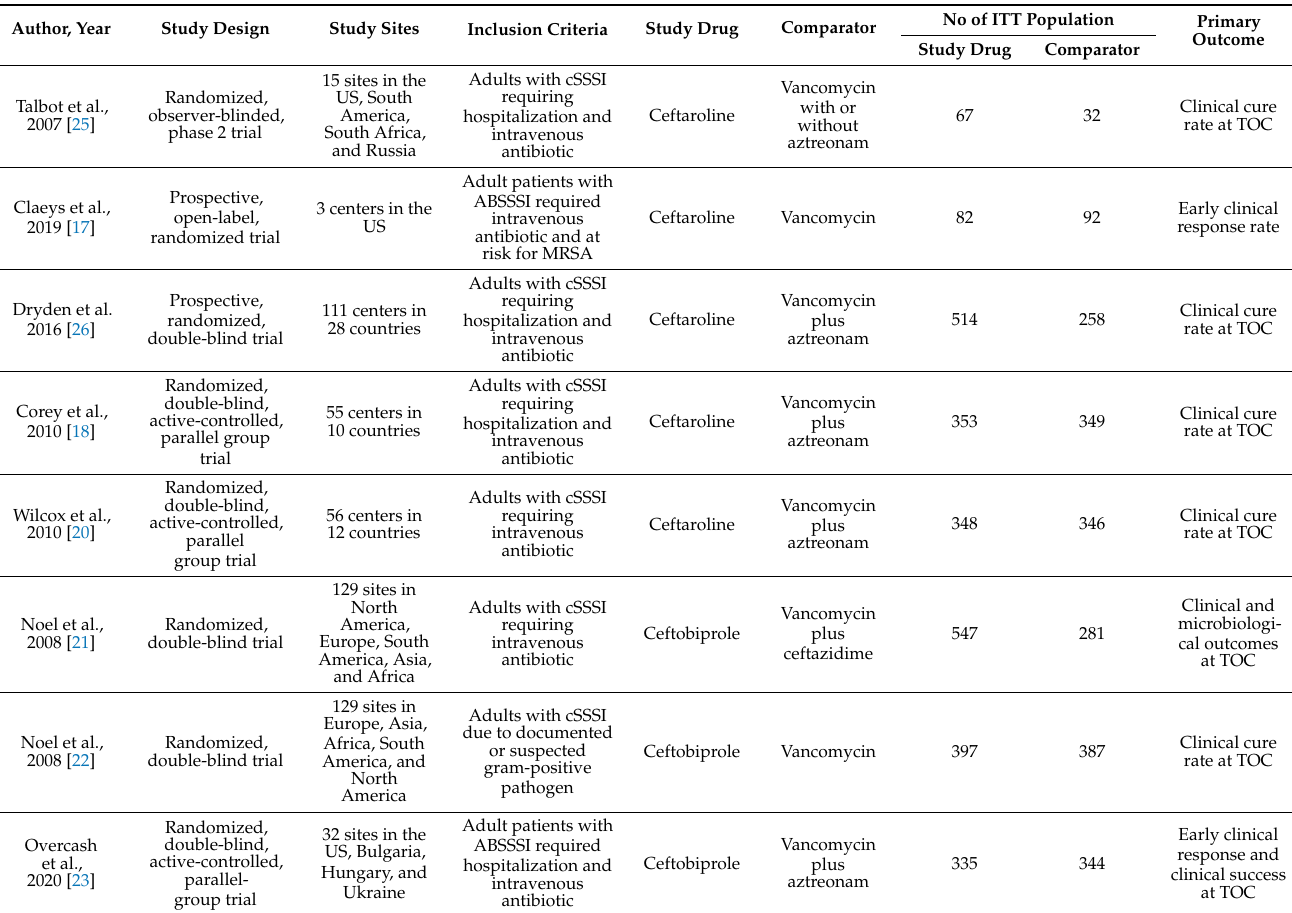
Table 1. Characteristics of the included